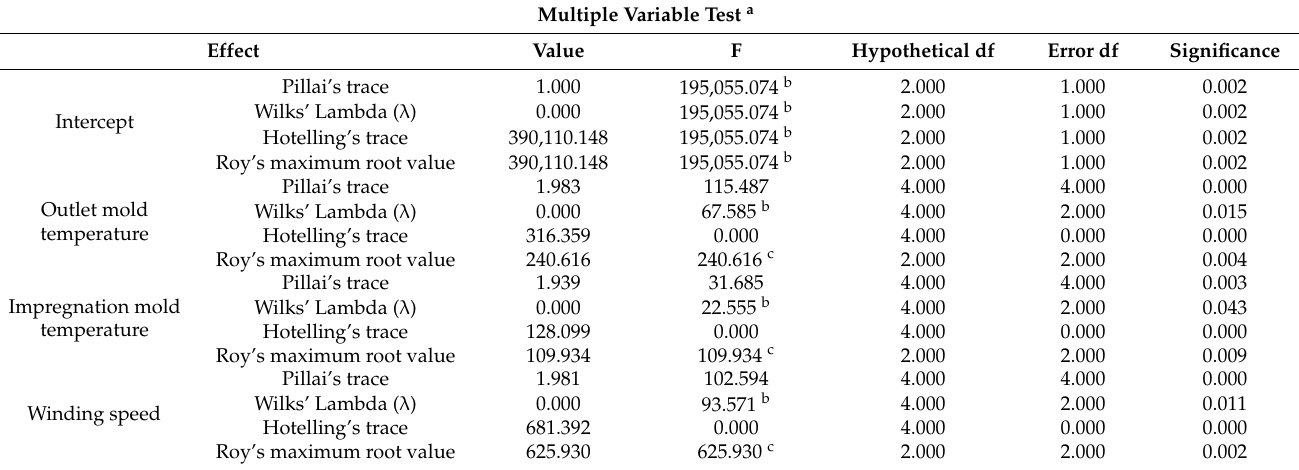
Table 8. Results of the multivariate variance analysis of CFRPF performance